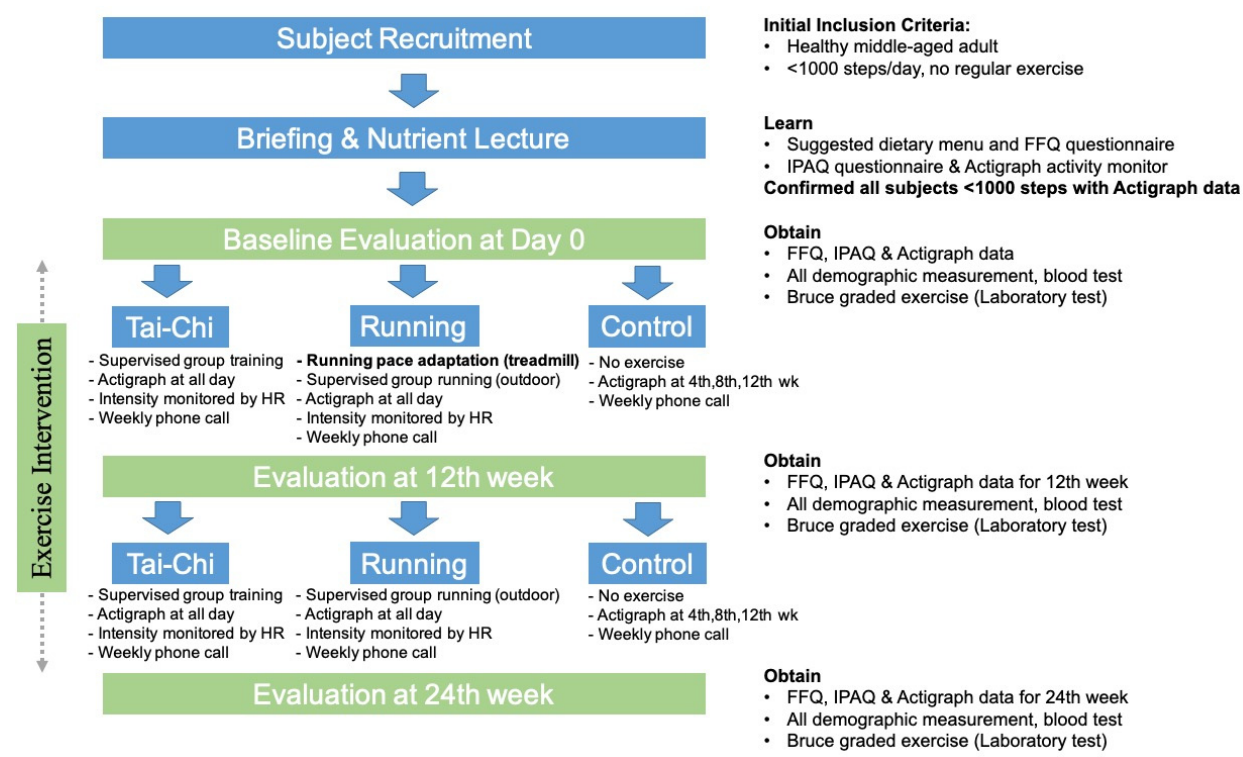
Figure 1. Experimental workflow for Tai-Chi, running and control groups.